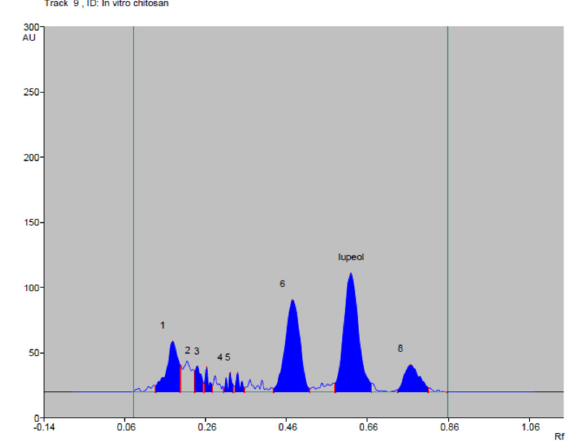
Figure 4d. HPTLC chromatogram of in vitro chitosan-treated